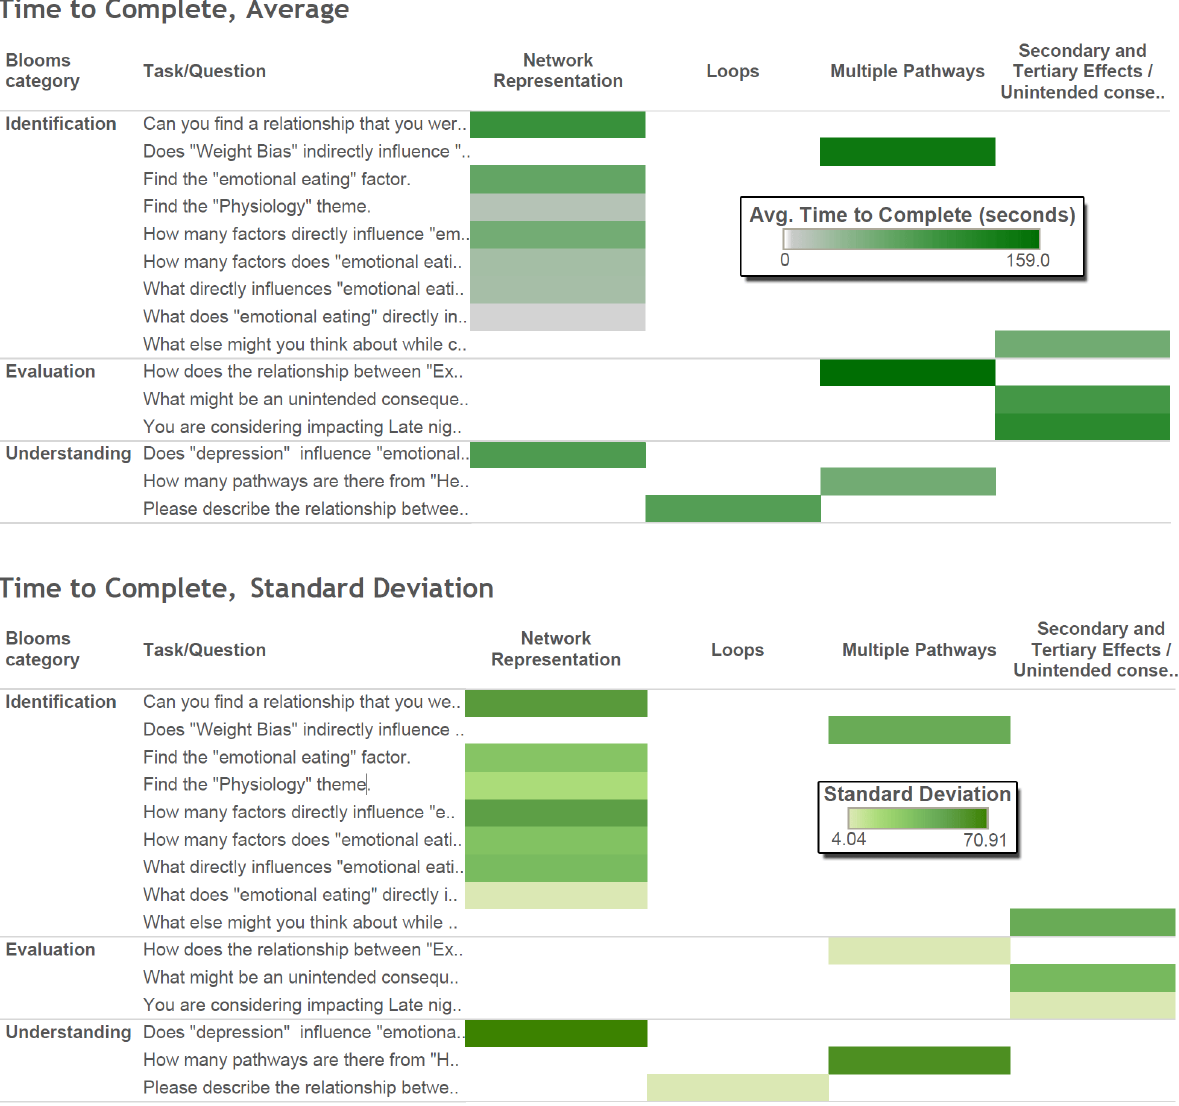
Figure 9. Average percentage of correct answers ( top ) and standard deviation ( bottom ) across all users.